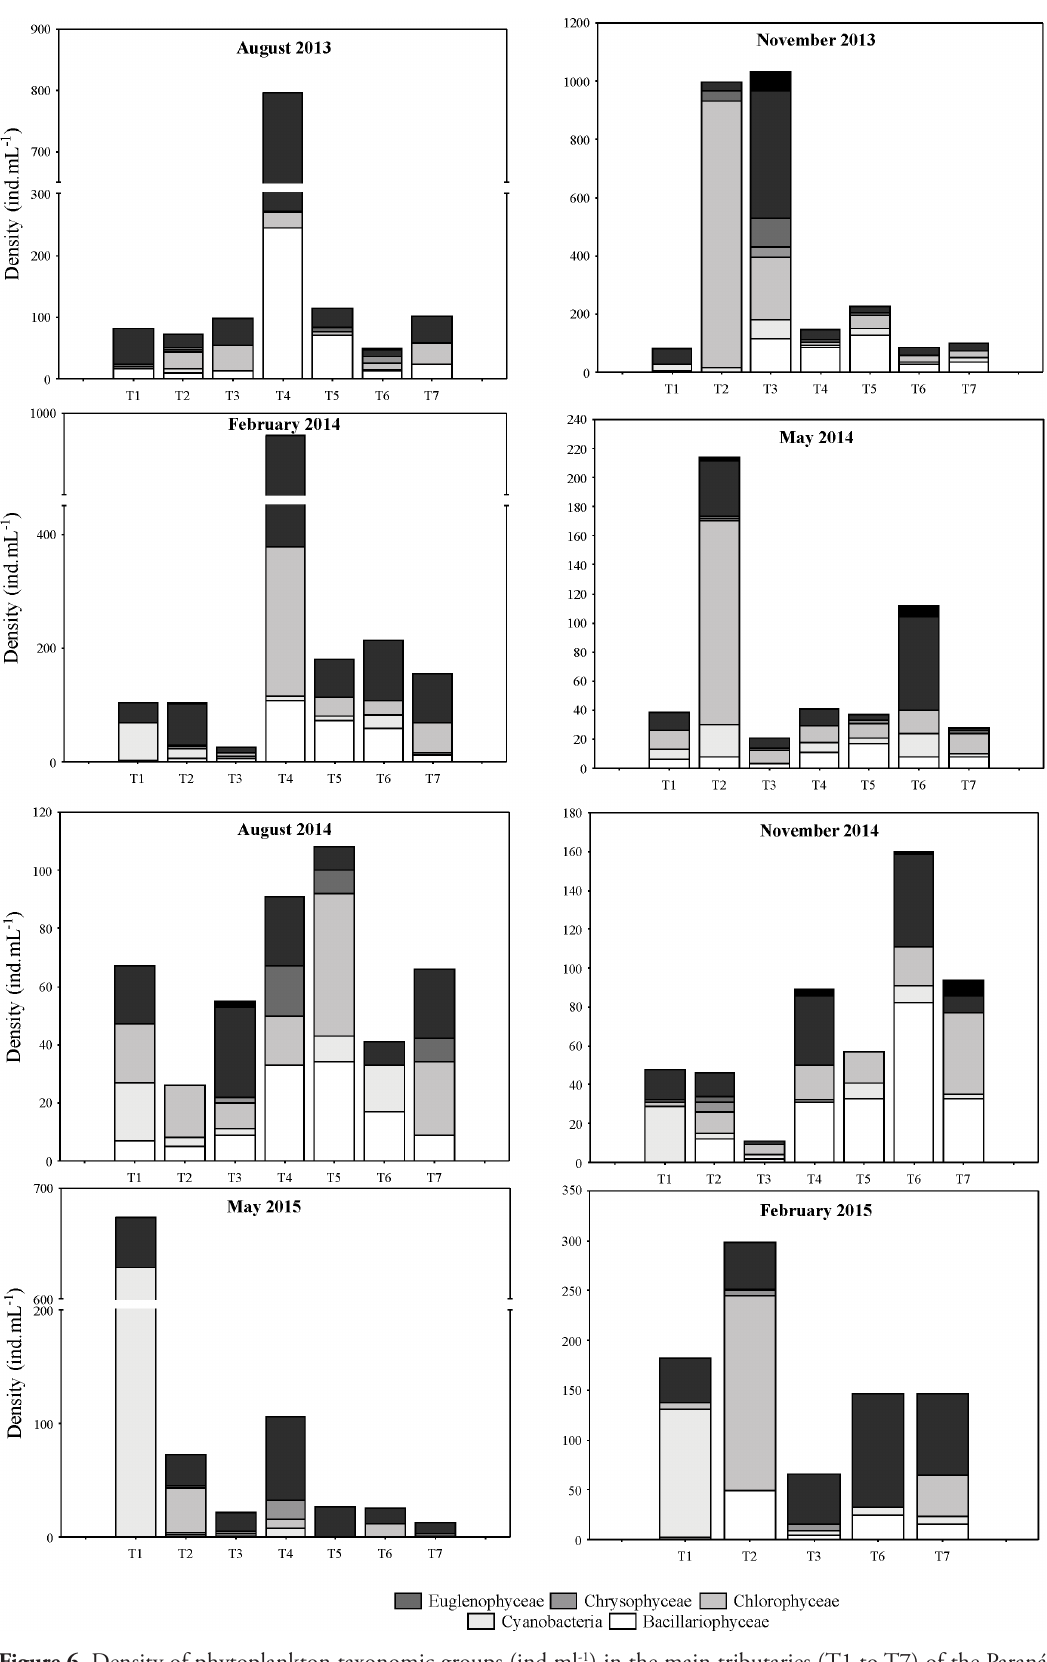
Figure 6. Density of phytoplankton taxonomic groups (ind.ml -1 ) in the main tributaries (T1 to T7) of the Paraná River sampled quarterly from August 2013 to May